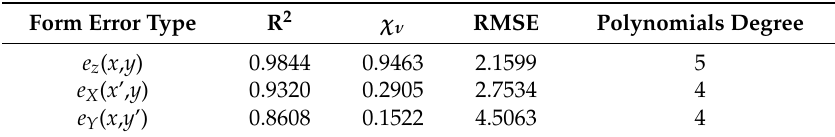
Table 1. Fitting performance of the polynomial models for the form errors of the grating. RMSE: root-mean-square error.